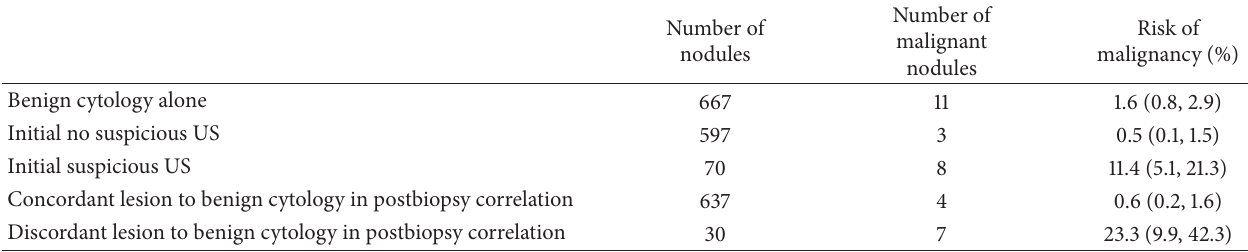
Table 3: Risk of malignancy according to initial US features and imaging-cytologic correlation in thyroid nodules with benign cytologic results.